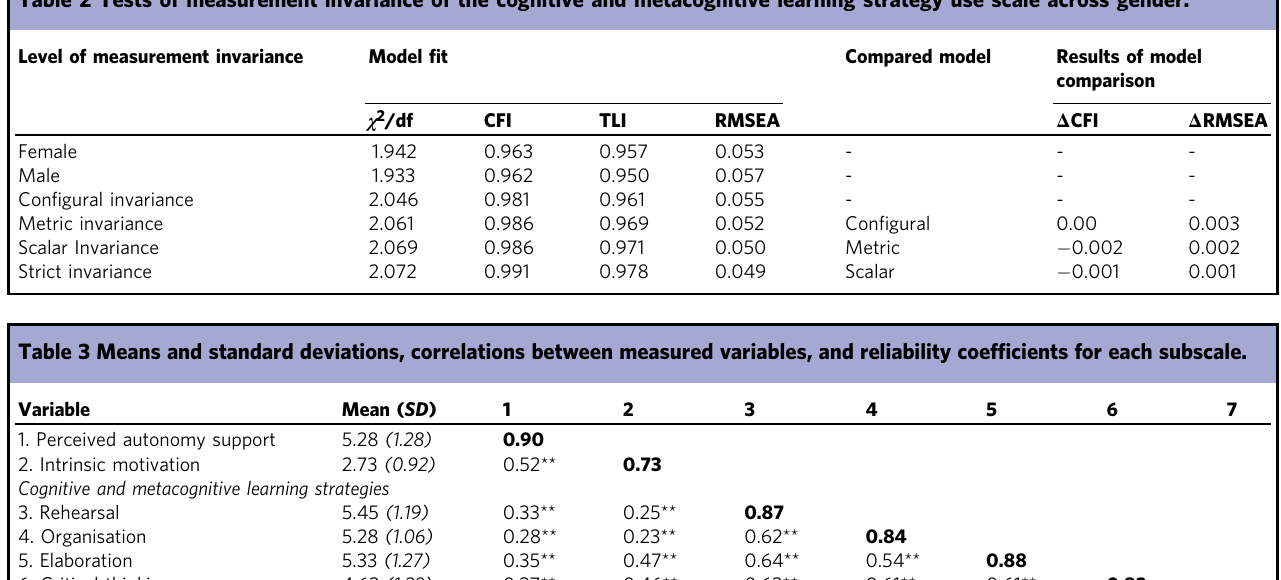
Table 2 Tests of measurement invariance of the cognitive and metacognitive learning strategy use scale across gender.